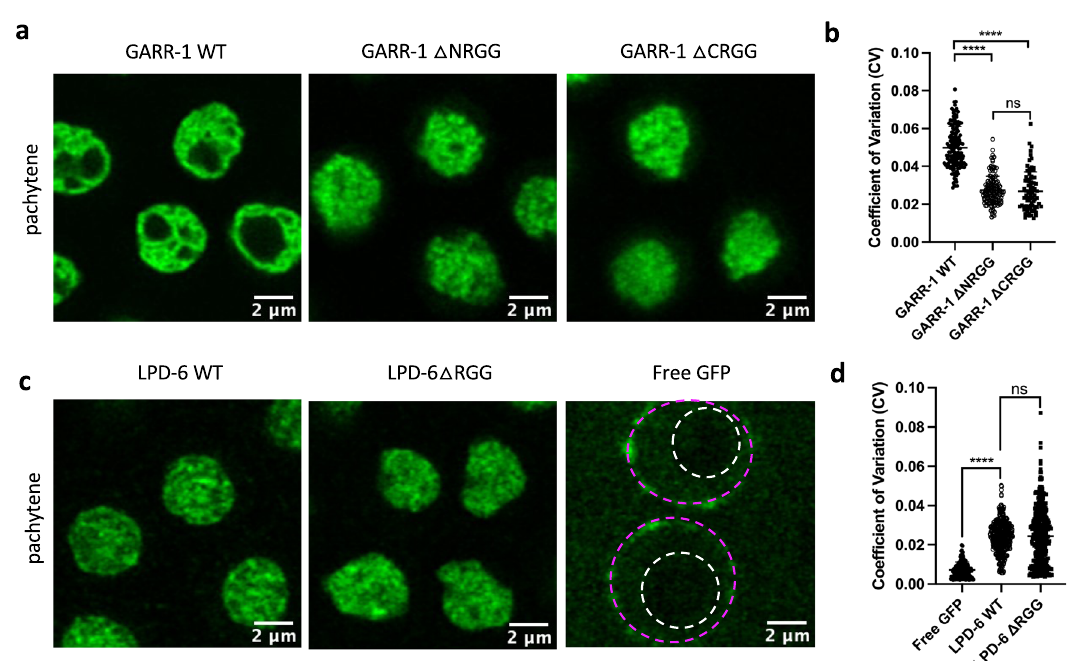
Fig. 5 | The GARR-1 N and C terminal RG/RGG domains contribute to sub- nucleolar organization in the germline. a GARR-1 WT localizes to the FC of pachytenegermcellnucleoli.GARR-1 Δ NRGGandGARR-1 Δ CRGGshowalossofthis compartmentalization b and decreased CV compared to WT ( n =152 nucleoli from 8 GARR-1 WT worms, 135 nucleoli from 8 GARR-1 Δ NRGG worms, and 84 nucleoli from6GARR-1 Δ CRGGworms).**** p <0.0001. c LPD-6 Δ RGGproteindoesnotshow differences in nucleolar organization compared to WT. Both LPD-6 WT and LPD-